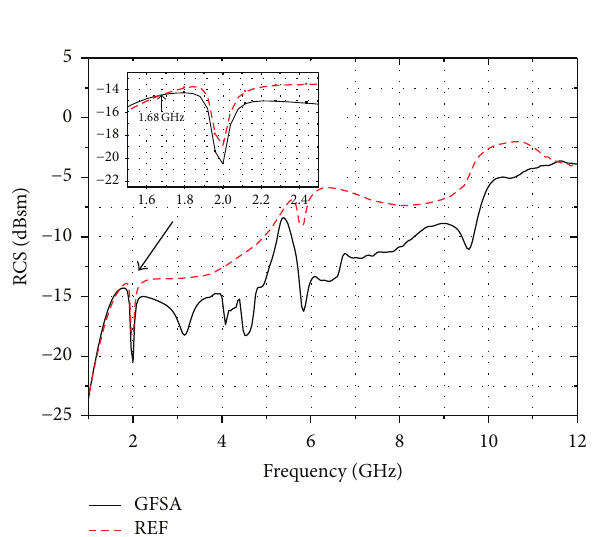
Figure 7: Bistatic RCS with observe angle.